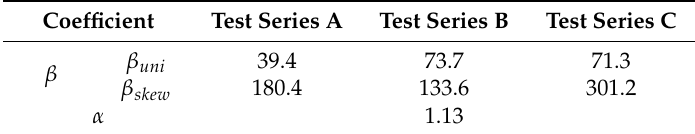
Table 4. Values of two coefficients to define uniform and skewed parts of shrinkage